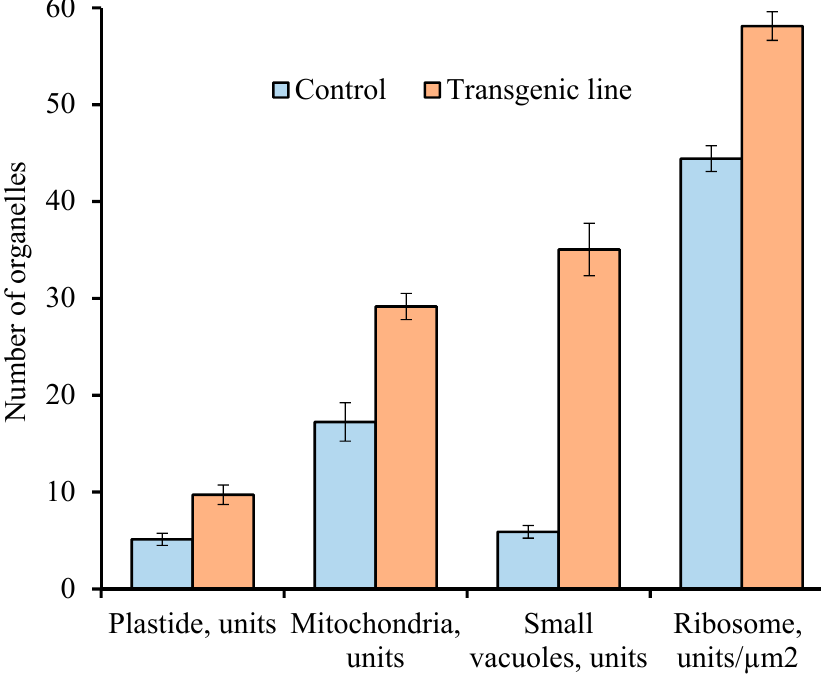
Figure 5. Comparative analyses of the number for different organelles per microspore section of the control plants and transgenic tomato line with abnormalities. Data points are the means ( n ≥ 150) and their standard errors ( α = 0.05).